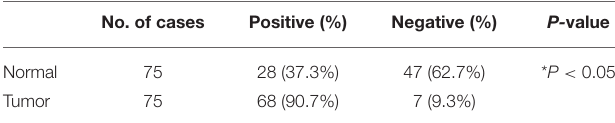
TABLE 1 | Expression of KDM2B protein in the normal colon tissue and colon cancer